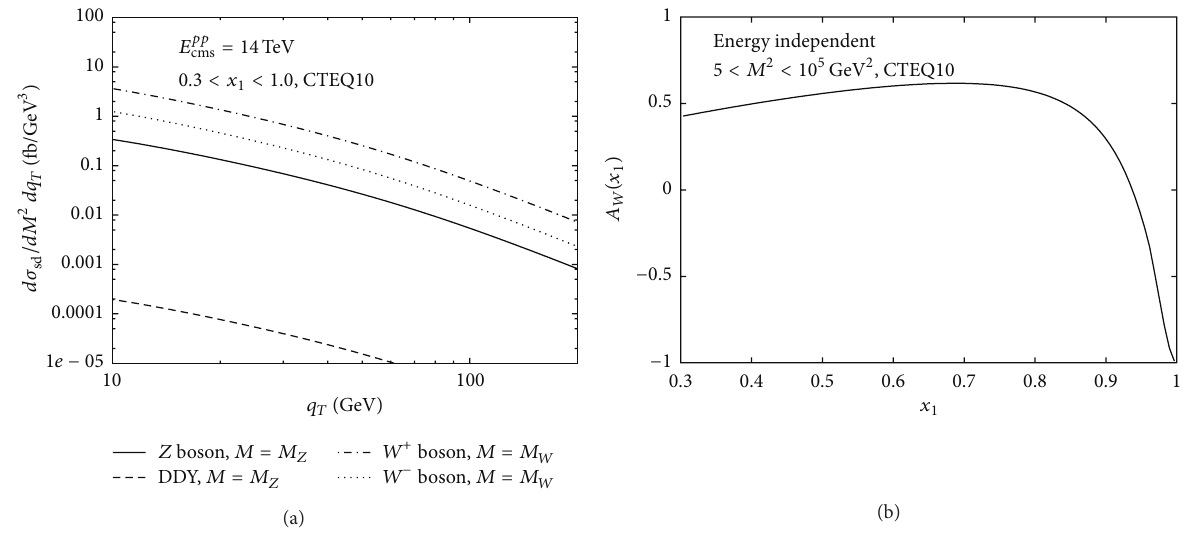
Figure 10: The lepton pair transverse momentum 𝑞 ⊥ distribution of the diffractive cross section at LHC √𝑠 = 14 TeV (a) and the charge asymmetry in SD 𝑊 ± cross sections at fixed 𝑀 2 = 𝑀 2 𝑊